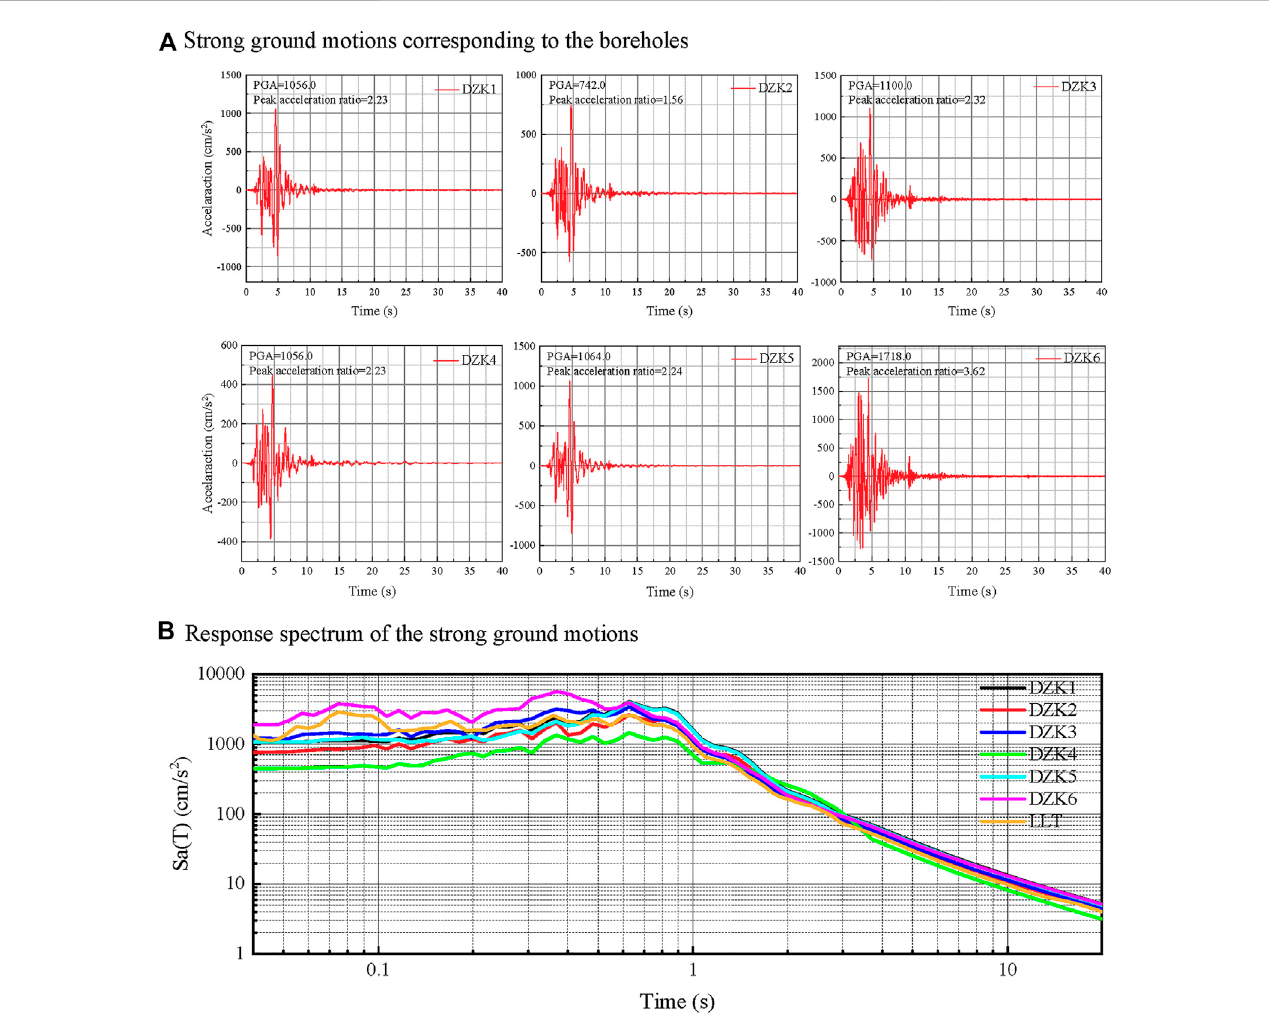
FIGURE 7 Site seismic response calculation based on one-dimensional equivalent linearization method.